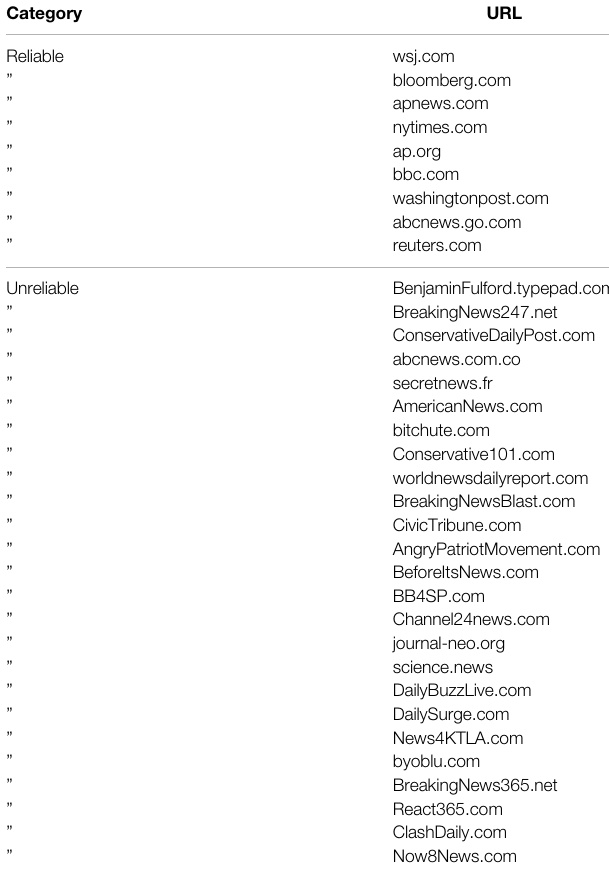
TABLE 1 | Original list of unreliable/reliable news websites used for this study. Along the list of unreliable news websites that deliver false information to deliberately/unintentionally misinform or deceive readers, a list of mainstream and well-respected news sources that publish credible content was analyzed. Each website listed in this table represents the starting node in the network growth